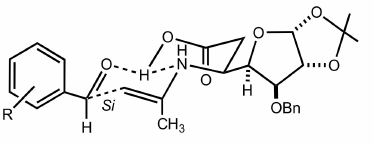
Figure 29. Favoured transition state leading to the ( S )-configured aldol.